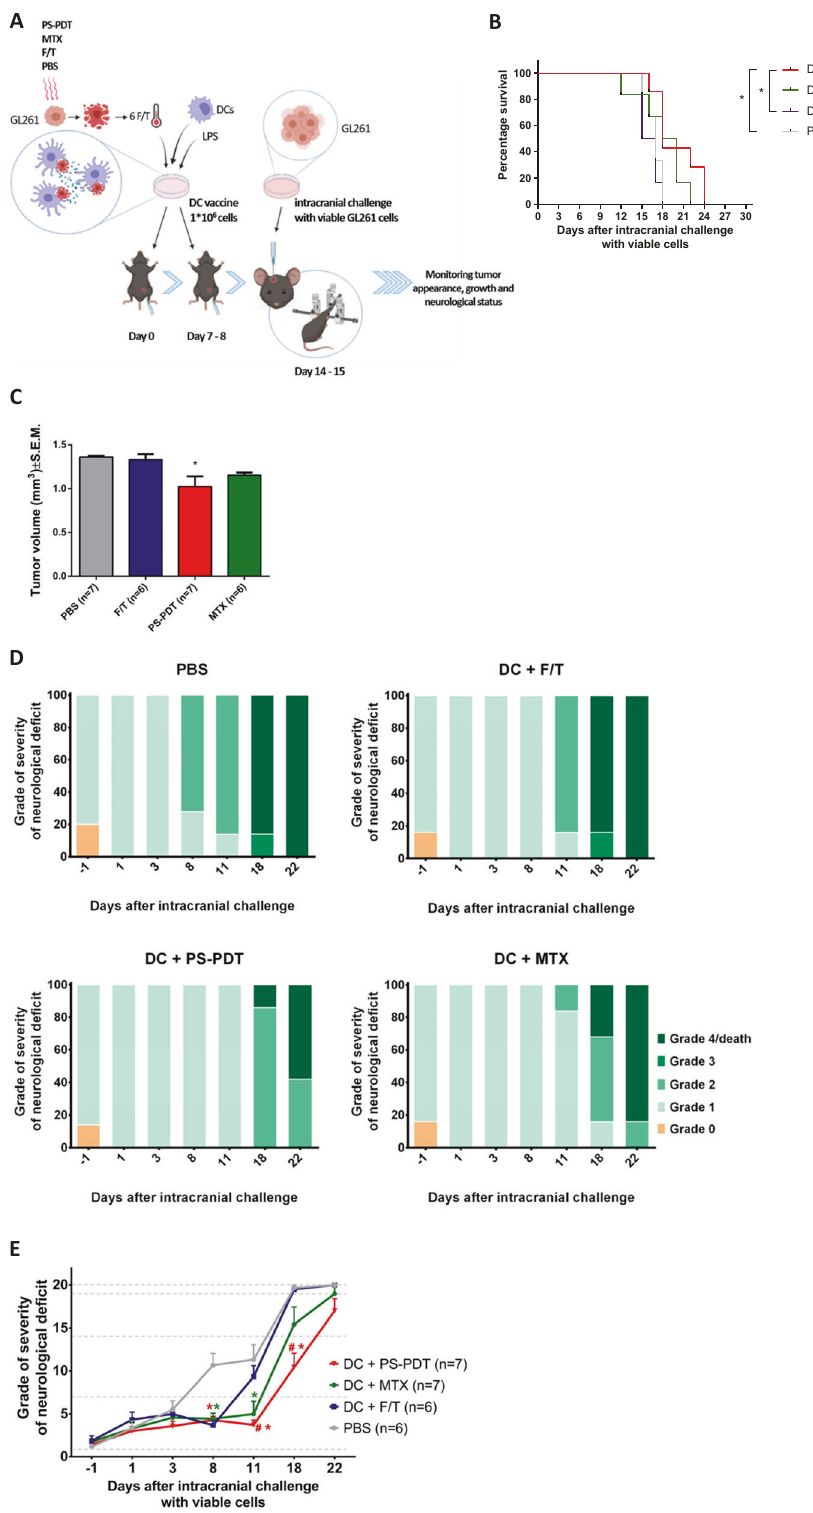
we tested the effectiveness of DC-GL261_PS-PDT vaccines in the therapeutic orthotopic mouse model (Suppl. Fig. 3A). We found that four consecutive DC-GL261_PS-PDT or DC-GL261_MTX vaccine injections signi fi cantly increased the median survival of glioma-inoculated mice by about 38% (37 days versus 51 days, p < 0.02) and also resulted in about 66% more long-term